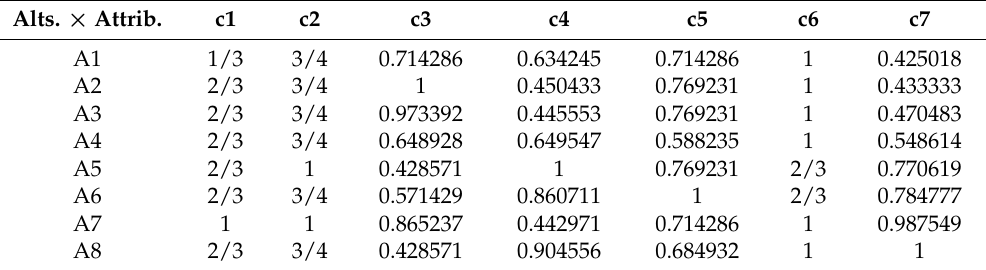
Table 1. Problem Dataset 1 (Matrix D’ ): recalculated normalized decision matrix. Alts. × Attrib.